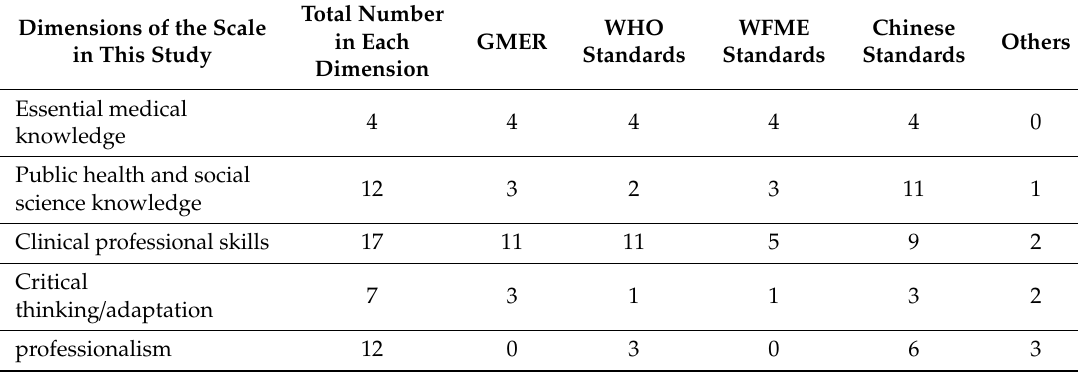
Table 2. Number of items from di ff erent resources in each dimension.